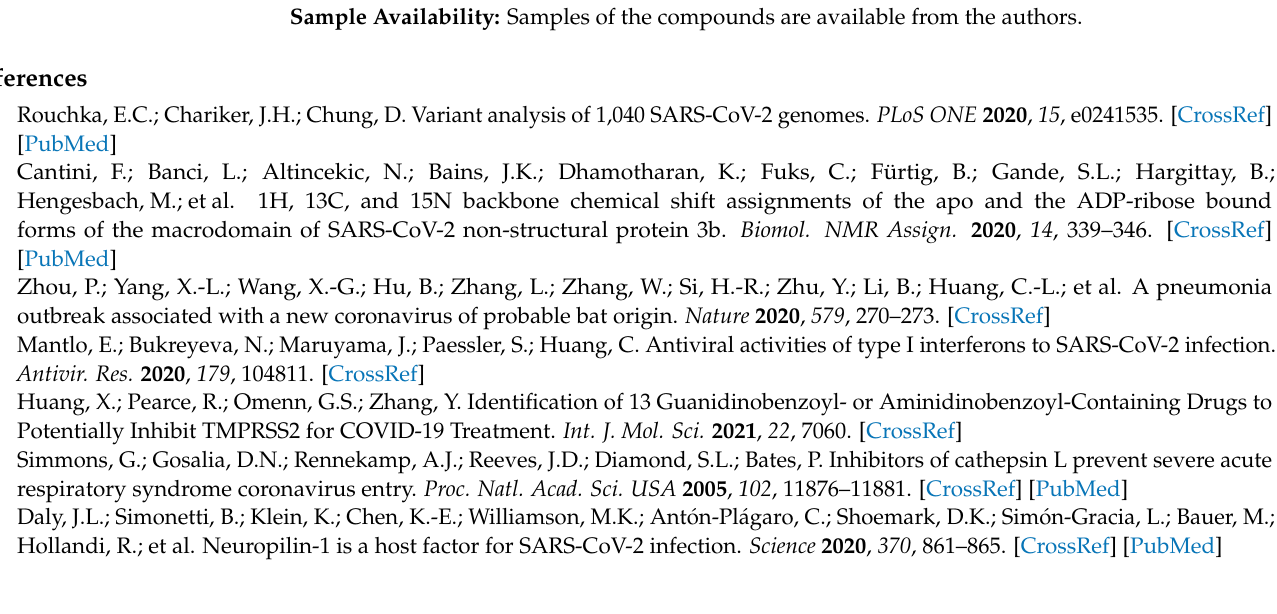
Supplementary Materials: Figure S1: The ligand-induced conformation changes of drug targets observed in crystal structures. a. The induced fit of BL2 loop in PLpro by GRL0617. The conformation of PLpro bound by GRL0617 was colored in blue (PDB code: 7CMD), the apo structure of PLpro was colored in brown, and the yellow region is GRL0617. Y268 and Q269 are two residues on the BL2 loop, which play an important role in the conformational rearrangement of the BL2 loop. b. The conformational changes of ACE2 induced by MLN-4760. The conformation of ACE2 bound by MLN-476 was colored in blue (PDB code: 1R4L), the apo structure of ACE2 was colored in brown, and the yellow region is MLN-4760. The binding of MLN-4760 induces a significant shift of the β -sheet on which T347 is located, and the α -helix on which D368 is located. It in turn induces a significant shift of the α -helices on which N53 and E56 are located. Figure S2: The t-distributed stochastic neighbor embedding (tSNE) map of the chemical spatial features including cLogP (calculated lipophilicity), HBA (hydrogen-bond acceptor), HBD (hydrogen-bond donor) and MW (molecular weight) for each CADD recommended compounds and the co-crystallized inhibitors against PLpro S3/S4 pocket (a) and DHODH (b). AL represents the inhibitors; Rule5 represents the CADD compounds that meet the criteria of MW ≤ 600, HBA ≤ 10, HBD ≤ 5, and − 2 ≤ cLogP ≤ 5; Highly_lipo refers to the CADD recommended compounds that violate one or more of the above criteria and cLogp > 2 (i.e., compounds with high lipophilicity); Highly_hydro refers to the CADD recommended compounds that violate one or more of the above criteria and cLogp < 2 (i.e., compounds with high hydrophilicity). Table S1: The solved crystal structures of the drug targets of COVID19 used in CADD studies. Table S2: The druggable sites of targets for the treatment of SARS-CoV-2 used in CADD studies. Table S3: The recommended compounds against Mpro of SARS-CoV-2 with activity assay in the corresponding CADD study. Table S4: The active inhibitors co-crystallized with drug targets against SARS-CoV-2. Table S5: The CADD compounds with high structural similarity to the Mpro